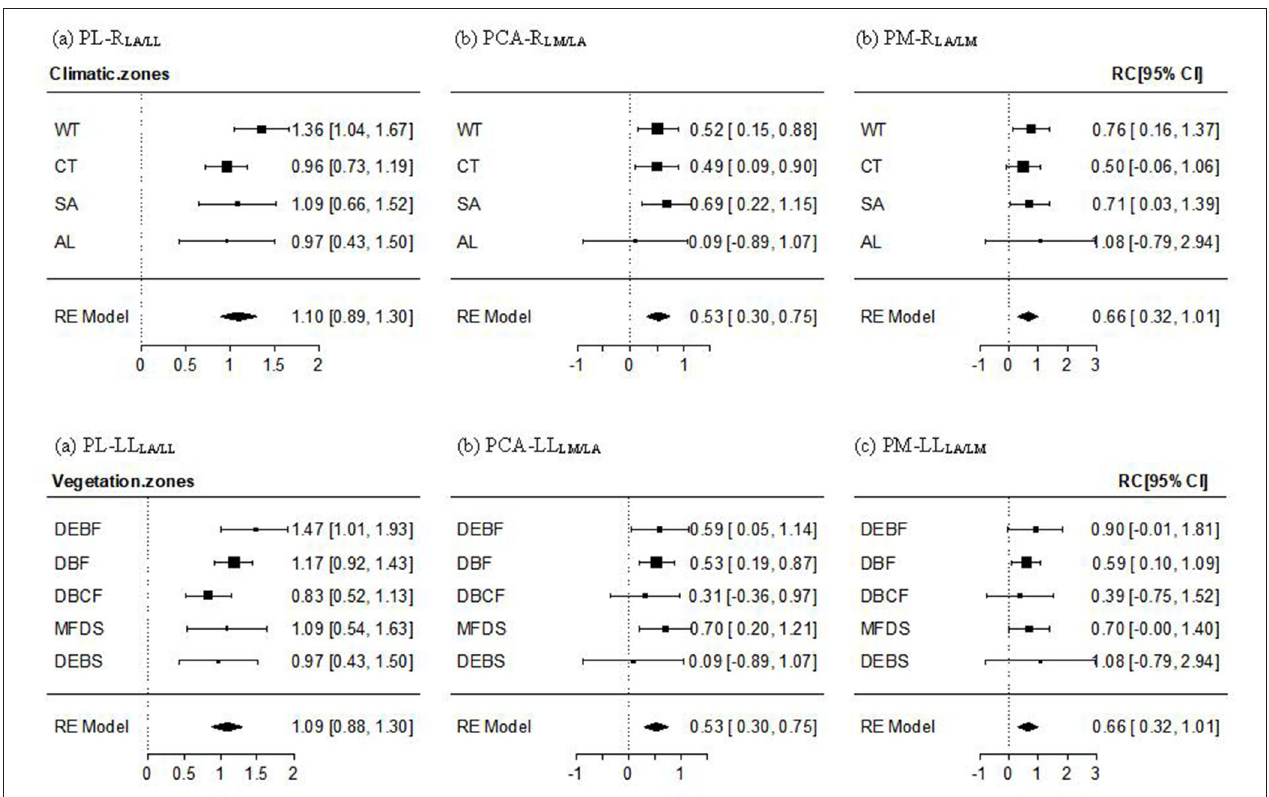
FIGURE 3 | Mean effect size and 95% confidence intervals of the PL–R LA / LL (a) , PCA–R LM / LA (b) , and PM–R LA / LM (c) relationship for different climate and vegetation zones. Abbreviations of leaf traits, climate zones, and vegetation types were as specified in Figure 2 . R LA / LL , R LM / LA , and R LA / LM were the regression residuals of LA on LL, LM on LA, and LA on LM,